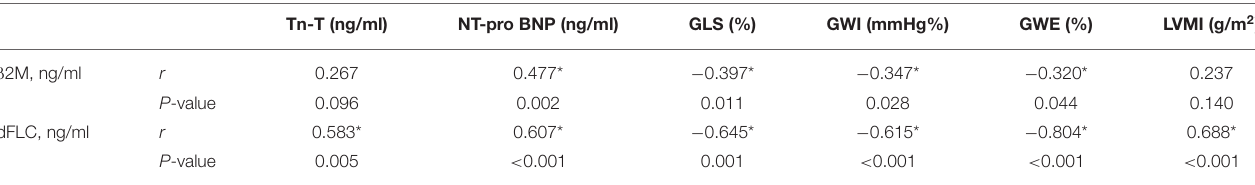
TABLE 4 | Correlation between MM biomarkers and cardiac function.